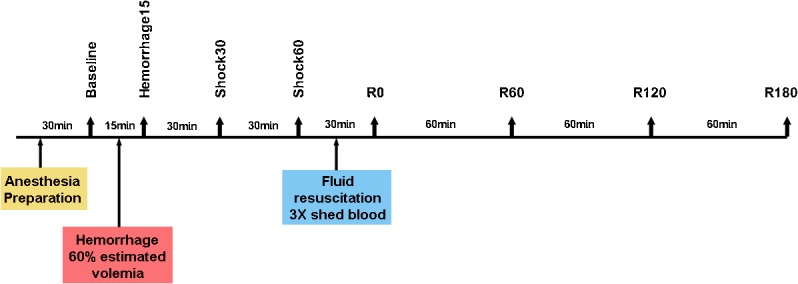
Experimental protocol.Baseline: before hemorrhage; Hemorrhage15: at the end of blood withdrawal; Shock30: 30 minutes after the end of blood withdrawal; Shock60: 60 minutes after the end of blood withdrawal; R0: at the end of fluid resuscitation; R60: 60 minutes after the end of resuscitation; R120: 120 minutes after the end of resuscitation; R180: 180 minutes after the end of resuscitation.